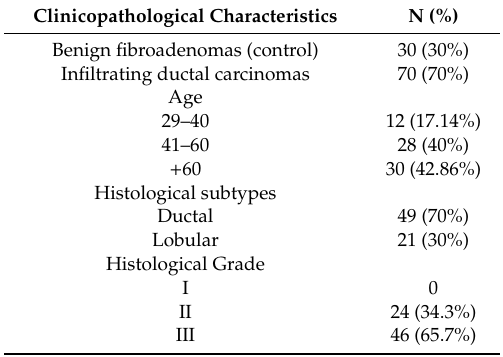
Table 1. Clinicopathological characteristics of patients included in the